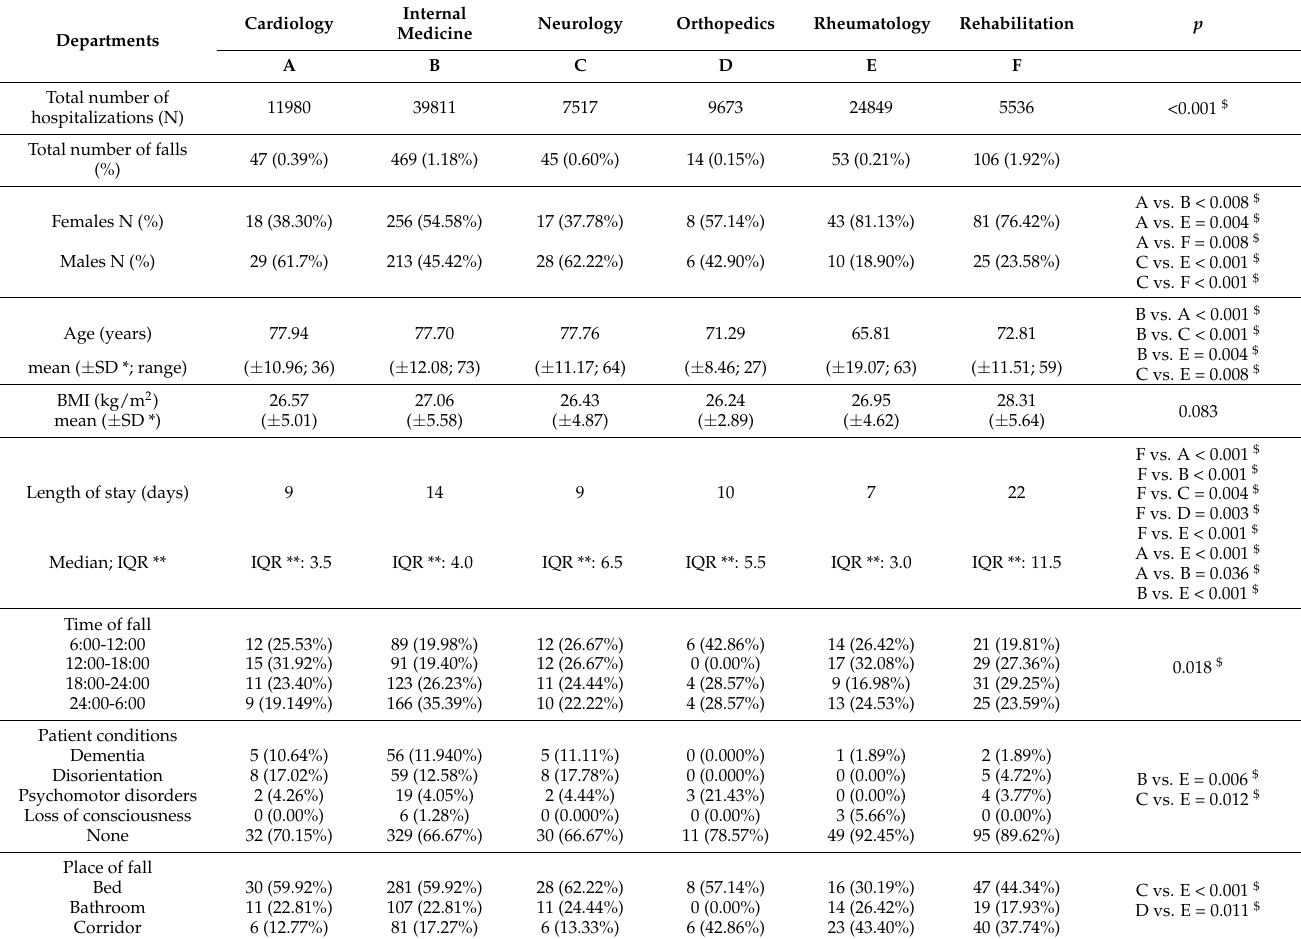
Table 1. Characteristics of fallers and circumstances of